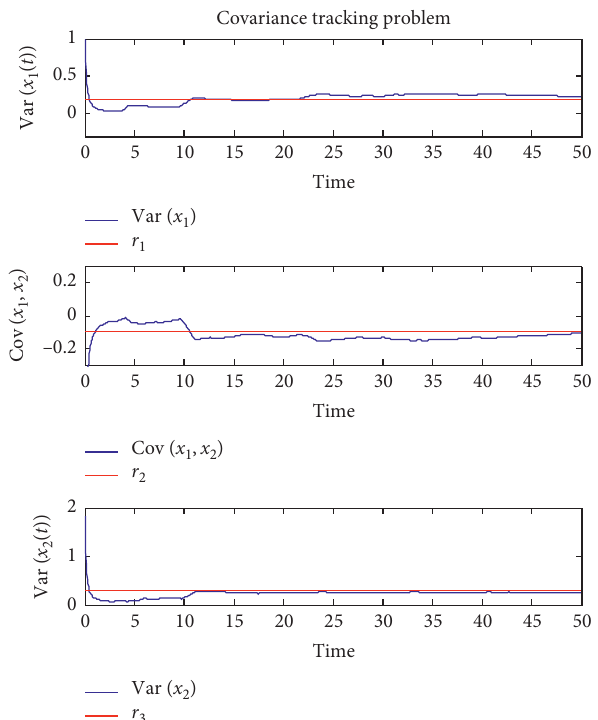
Figure 5: States variance and desired states variance.